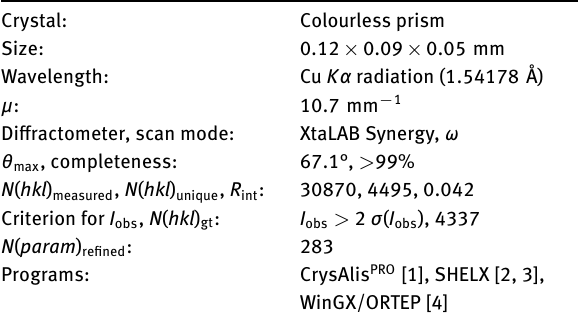
Table 1: Data collection and